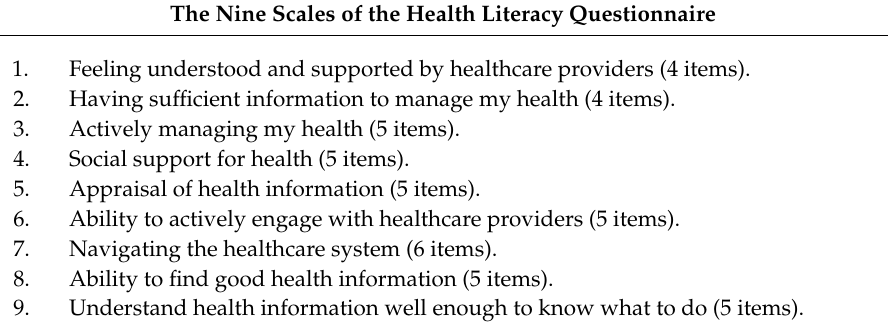
Table 1. Health Literacy Questionnaire (HLQ)